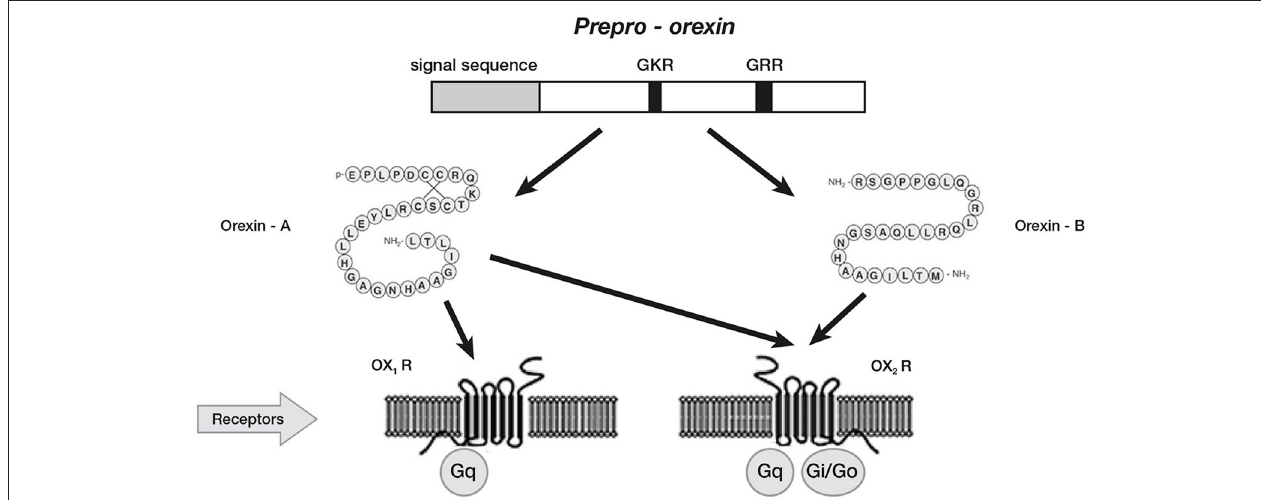
FIGURE 3 | Loss of orexin signaling could cause cataplexy by reducing activity in motor excitatory systems of brainstem or by providing less suppression of the motor inhibitory systems. Loss of orexin could cause sleepiness by reducing activity in the cholinergic and monoaminergic arousal systems or by reducing inhibition of sleep-promoting neurons in the rostral hypothalamus (preoptic